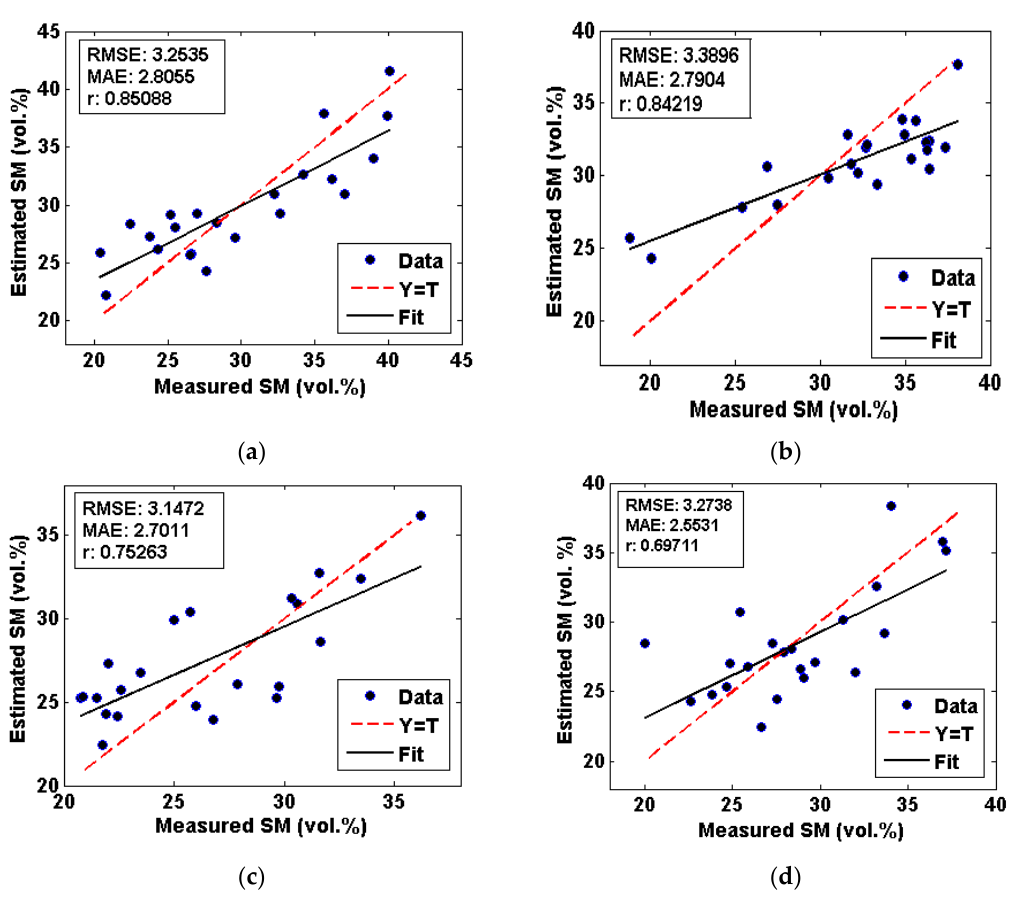
Figure 7. The relationship between the measured and estimated soil moistures (SM) over testing areas 1–4 for Dataset 1 ( a – d ), respectively.